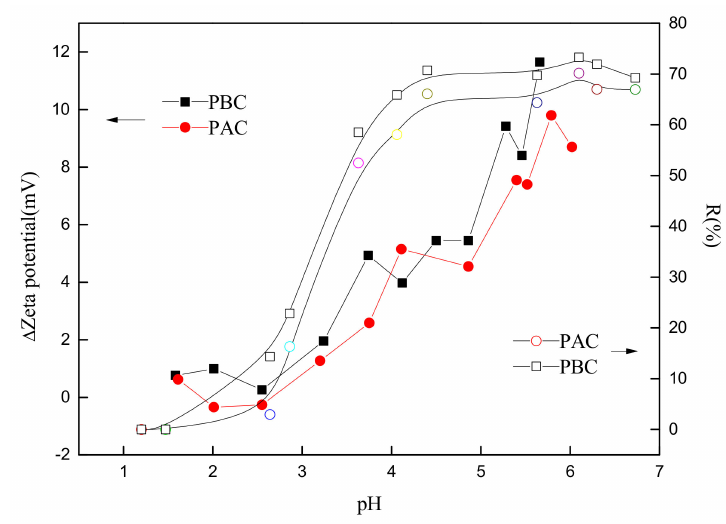
Figure 8. Relationship of removal rate and the change of zeta potential of cuticle before and after Sr adsorption by adaxial (PAC) and abaxial (PBC) cuticle of Photinia serrulata Leaf.